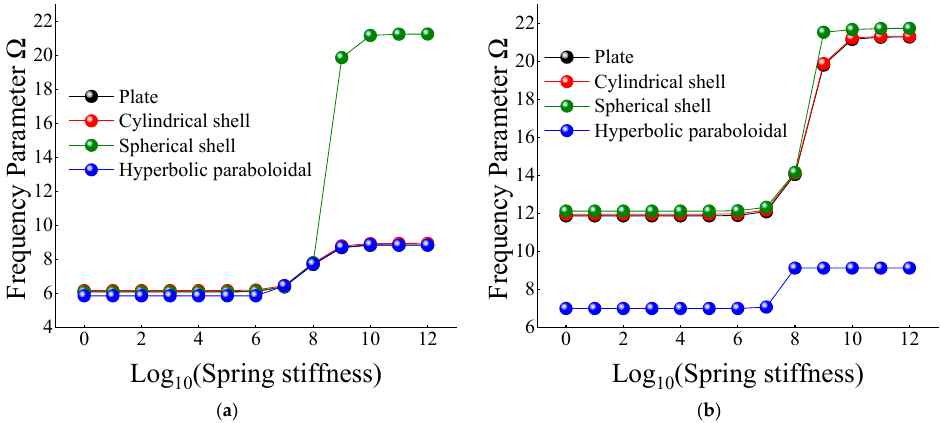
Figure 10. Variation laws of the frequency parameter Ω for composite shallow [0 ° /90 ° ] shells with various stiffness constant K ϕ x by FSDT. ( a ) m = 1; ( b ) m = 2.